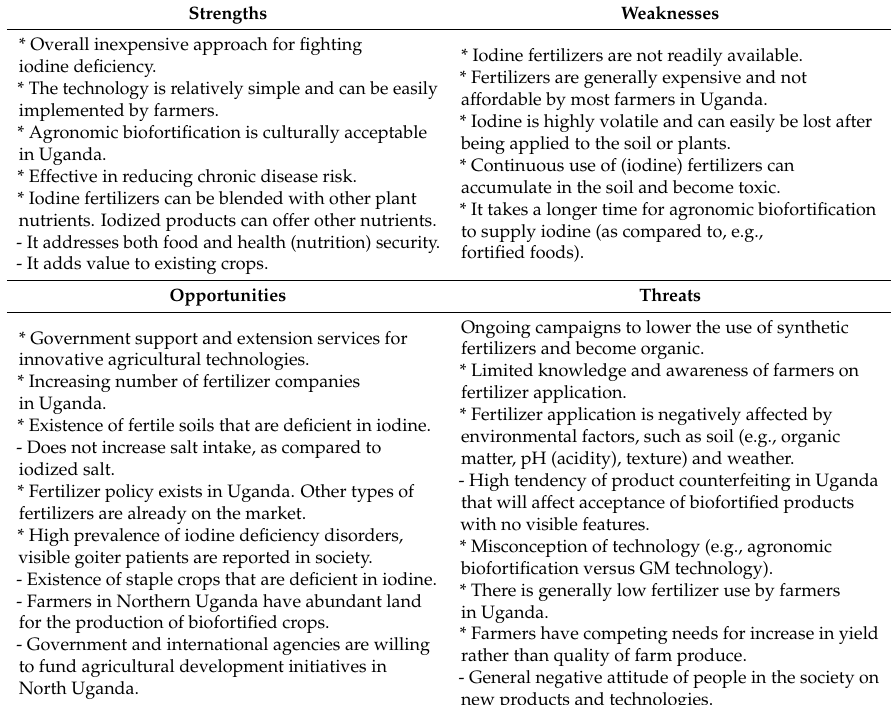
Table 2. Key Strengths, Weaknesses, Opportunities and Threats (SWOT) factors as perceived by all stakeholders in the focus